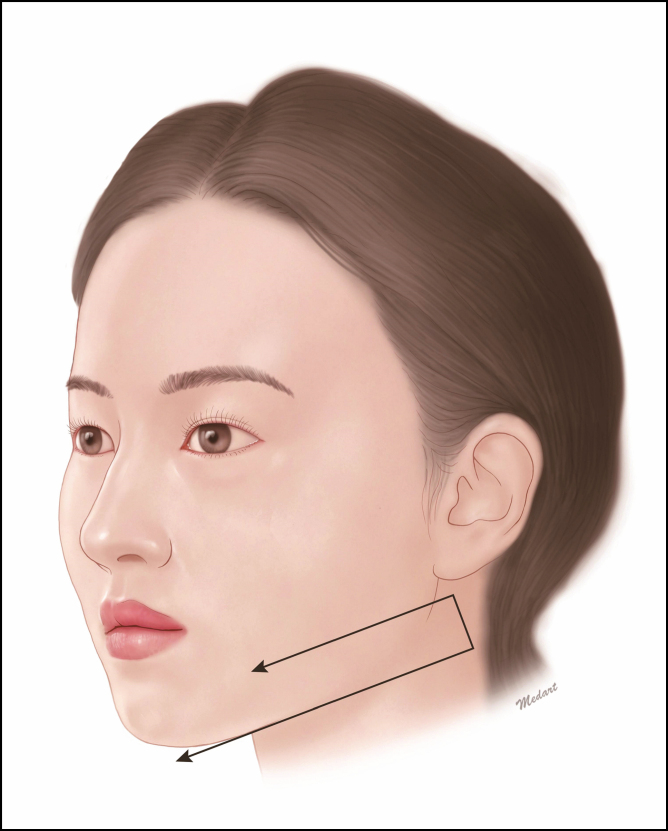
Staple-shaped procedure below the ear. The entry point is located in the platysma-auricular ligament below the ear and the exit one is determined in the jowl on one side and the supraplatysmal fat.